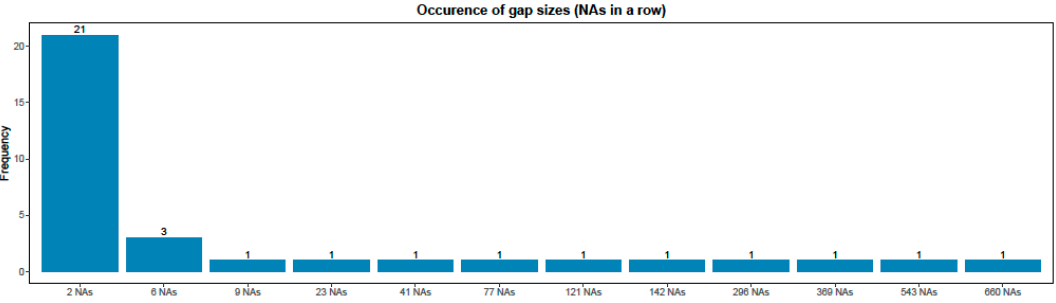
Figure 5. Occurrence of gap sizes.